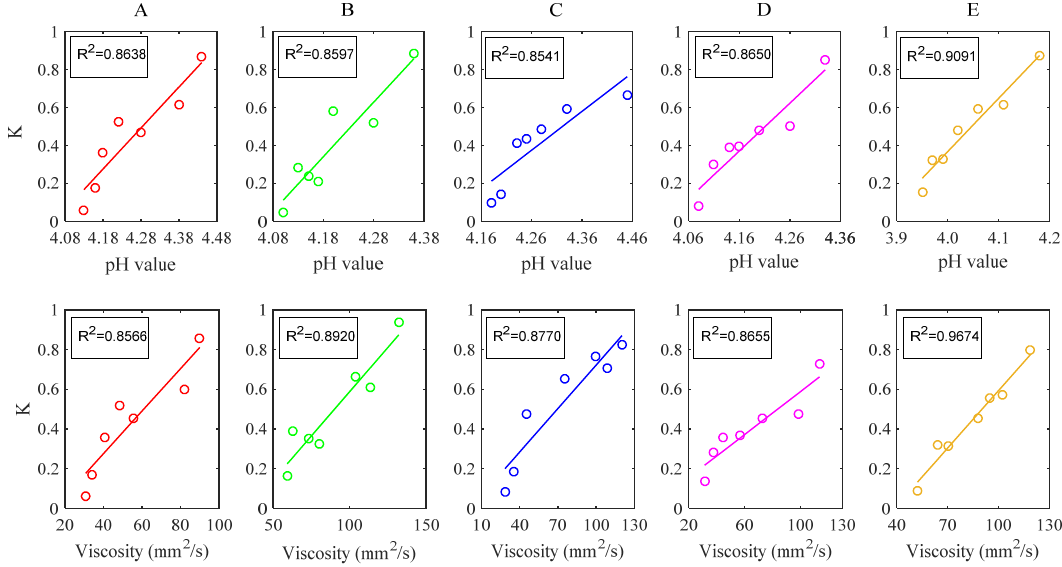
Figure 7. Predicted pH value and viscosity of yogurt samples based on MLR model.